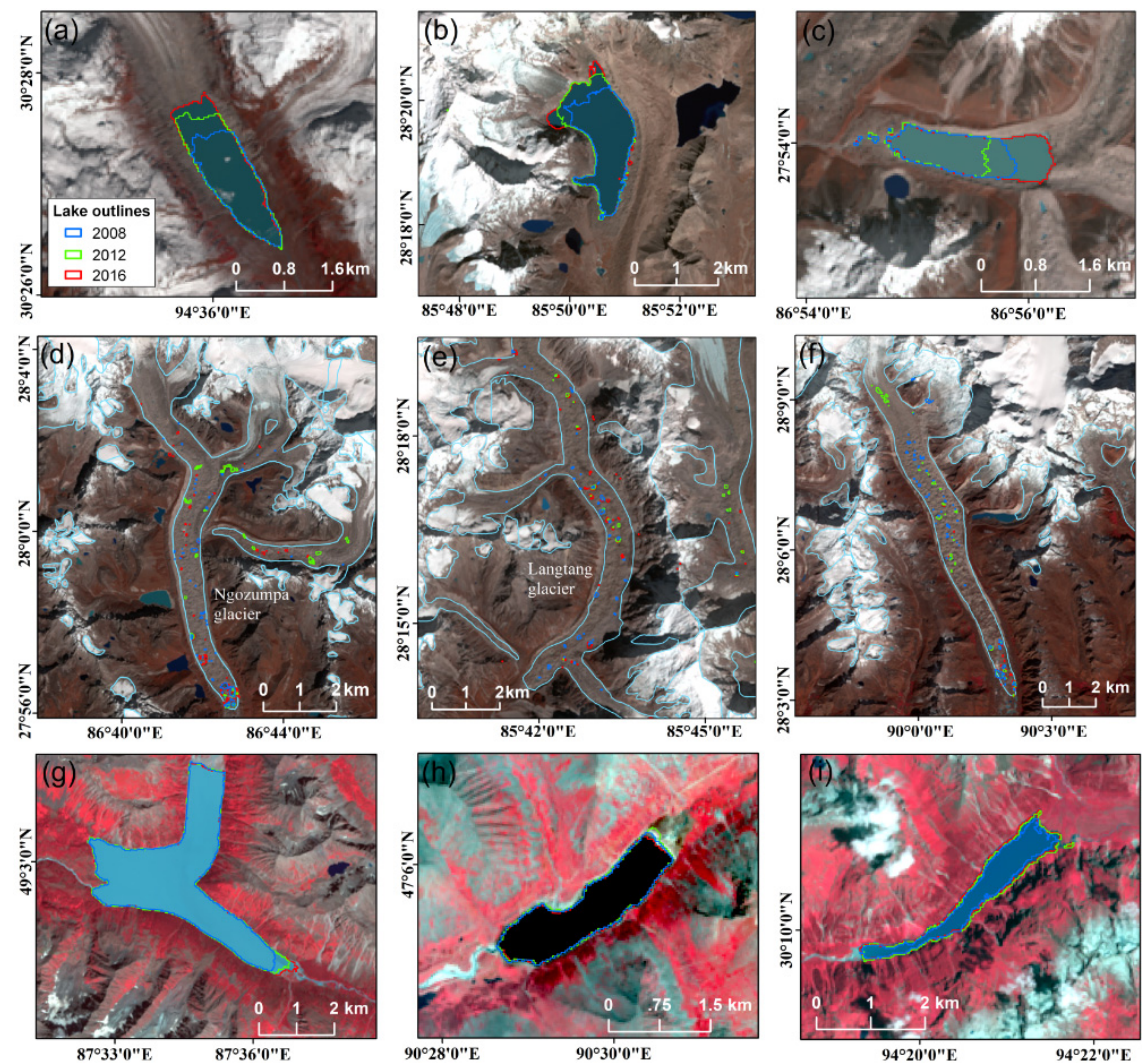
Figure 6. Evolution of different types of glacial lakes: ( a – c ) proglacial lakes; ( d – f ) supraglacial lakes; and ( g – i ) unconnected glacial lakes. Background images were derived from USGS Landsat 8 satellite data for 2016.